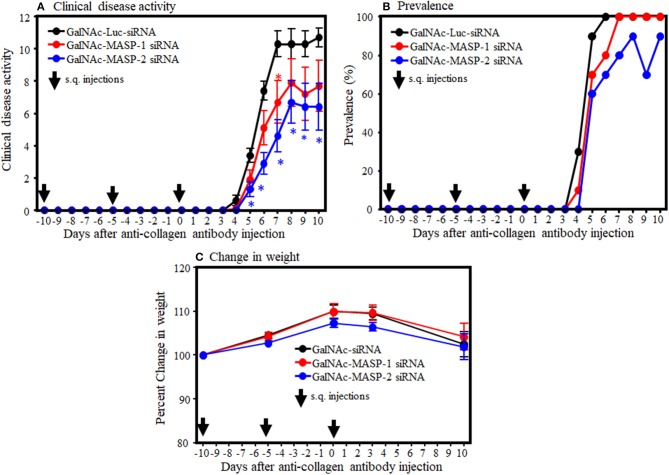
Partial decrease in the clinical disease activity in WT mice treated with GalNAc-MASP-2-siRNA but not with GalNAc-MASP-1 duplex. GalNAc-Luciferase-siRNA was used as negative control compared to GalNAc-MASP-1-siRNA or GalNAc-MASP-2-siRNA. Arthritis, in C57BL/6 mice, was induced by injecting a mixture of five anti-collagen monoclonal antibodies as described in the Methods. WT mice were injected three times s.q with Luciferase siRNAs as a negative control or with GalNAc-MASP-1-siRNA or GalNAc-MASP-2-siRNA at day −10, 0 and at day 3. Disease in mice was checked from day 4 to 10. (A) CDA in mice treated with GalNAc-Luciferase-siRNA or GalNAc-MASP-1-siRNA or GalNAc-MASP-2-siRNA. (B) Prevalence (%) of disease, in mice treated with GalNAc-Luciferase-siRNA or GalNAc-MASP-1-siRNA or GalNAc-MASP-2-siRNA. (C) Change in weight (%) in mice treated with GalNAc-Luciferase-siRNA or GalNAc-MASP-1-siRNA or GalNAc-MASP-2-siRNA. Data shown represent the mean ± SEM based on WT mice injected s.q. with GalNAc-Luciferase-siRNA, n = 30 and with GalNAc-MASP-1-siRNA (n = 10), GalNAc-MASP-2-siRNA (n = 10). *p < 0.05 in comparison to mice to GalNAc-Luciferase-siRNA injected mice (n = 10).